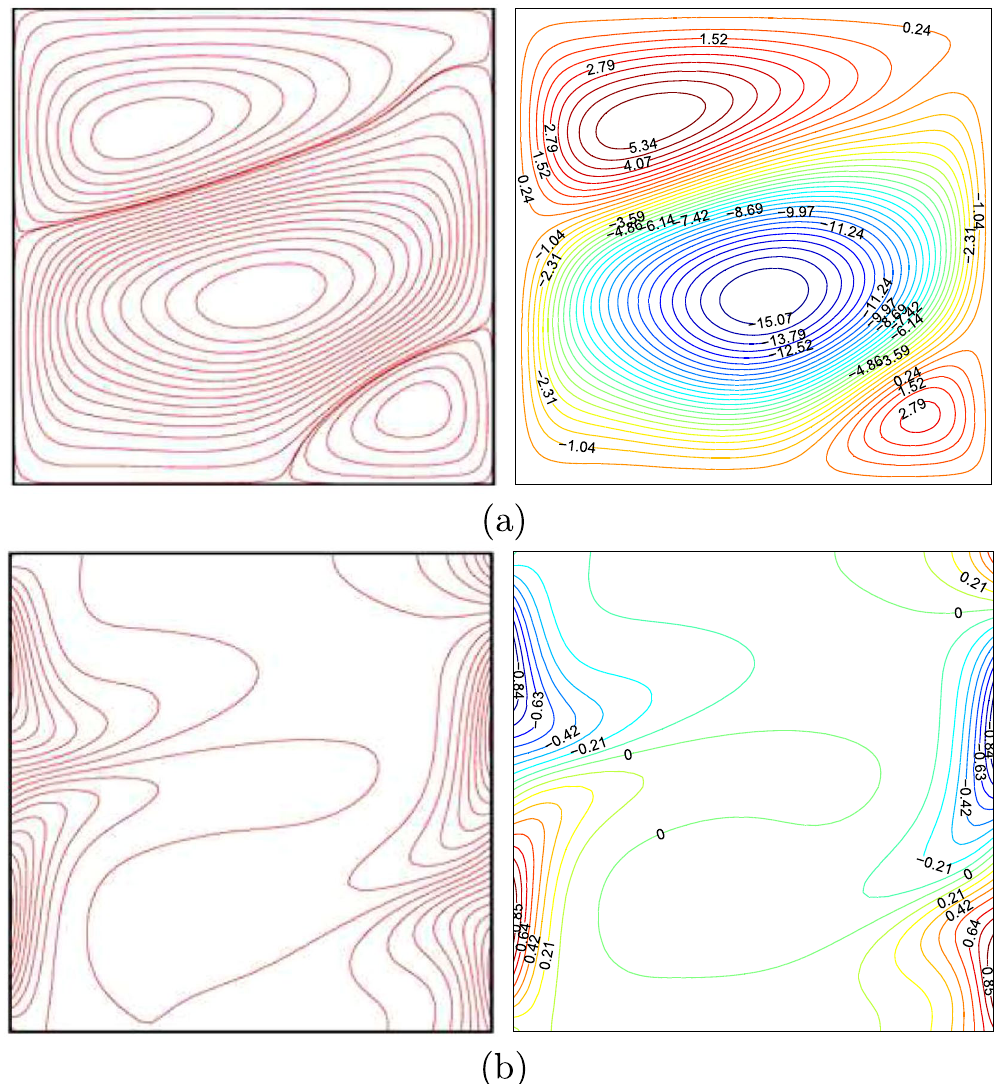
Figure 3. Streamlines ( a ), Deng and Chang 28 (left), present study (right), isotherms ( b ), Deng and Chang 28 (left), present study (right) for φ = 0, ϕ = 0 and Pr = 0.71.